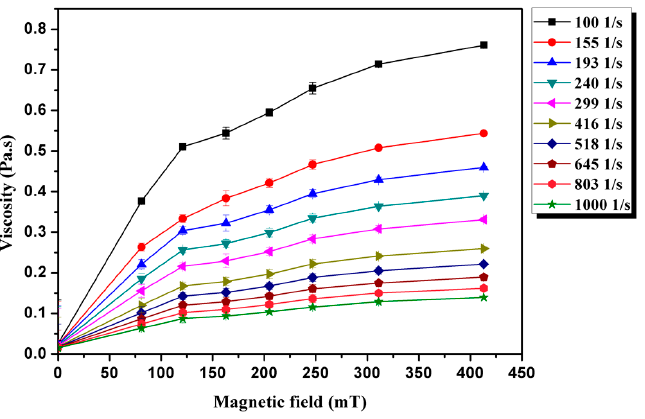
Figure 8. The viscosity of Fe-based amorphous MF as a function of magnetic field. Dynamic oscillatory testing was conducted under angular frequency sweep. Storage modulus G (cid:48) and loss modulus G (cid:48)(cid:48) were characterized as a function of frequency at room temperature under angular frequency sweeps of 0.1–100 rad/s at 0.1%, 0.5%, and 1%